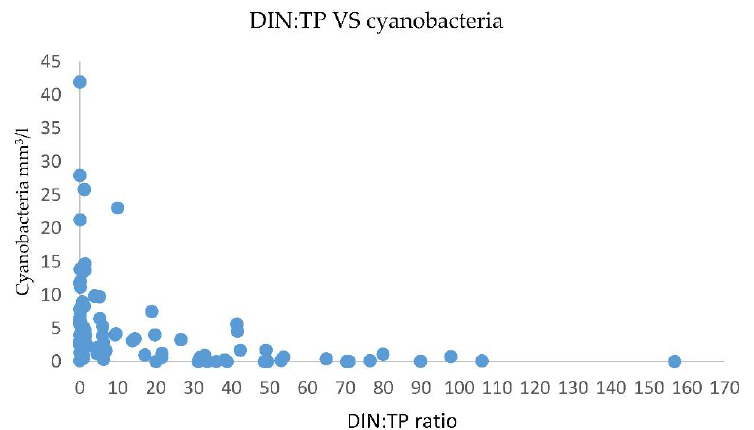
Figure 6. Plot of DIN:TP and cyanobacteria biomass; it is likely to conclude that low DIN:TP (<10) corresponds cyanobacteria peaks. Table 1. Correlations between concentration of cyanobacteria and TN, DIN (dissolved inorganic nitrogen), TP, DP (dissolved phosphorus), TN:TP, and DIN:TP in Lake Vombsjön, and resulting p - values (Spearman’s rs).